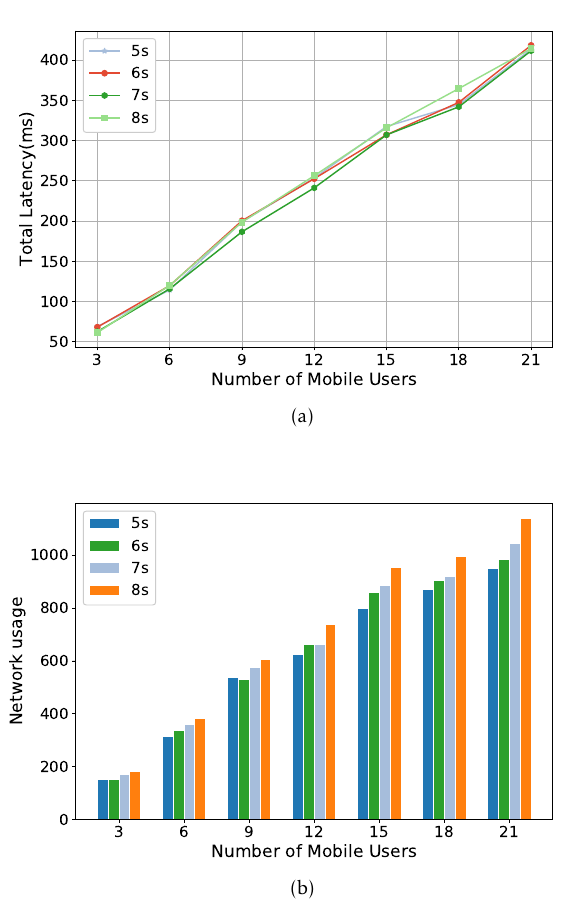
Figure 2. The impact of UEs’ average sojourn time with di(cid:27)erent number of users.(a) Total service latency perceived by users. (b) Network usage.